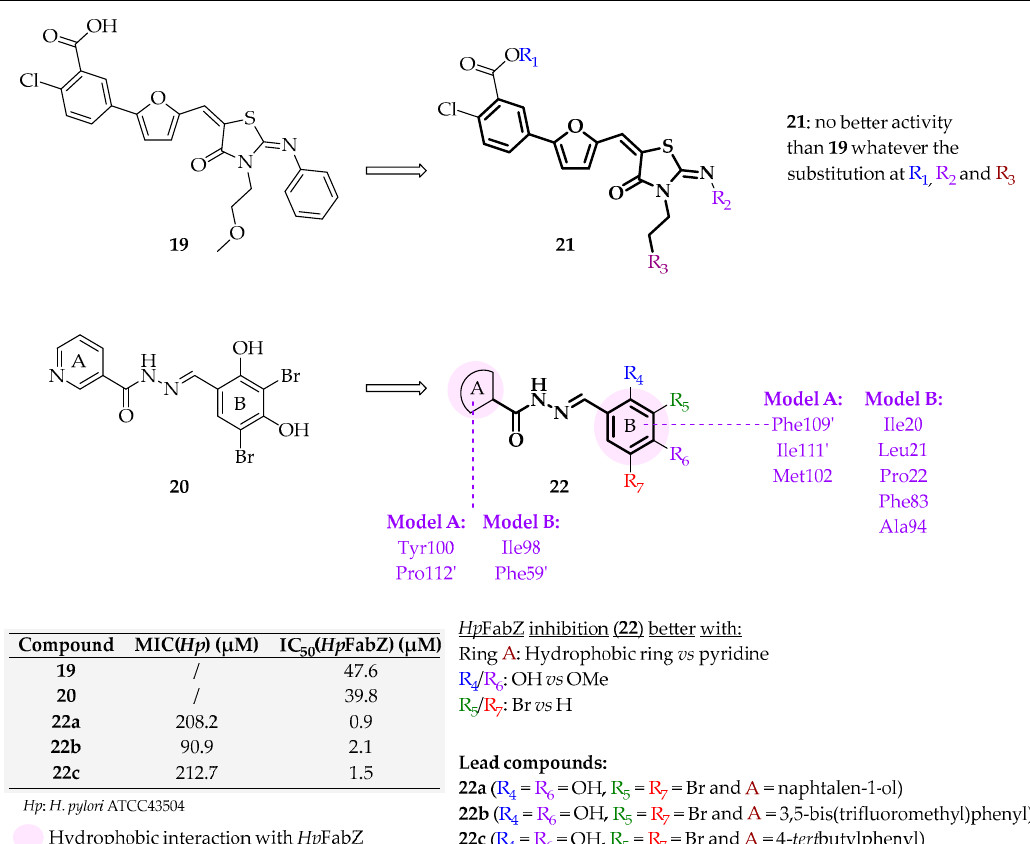
Figure 22. Structure, SAR and representation of main interactions with Hp FabZ of Schiff bases 19–22 and in vitro activities of lead compounds [102].